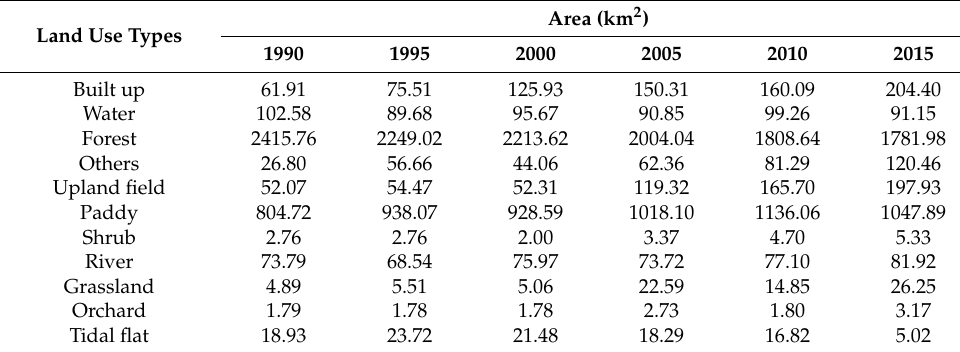
Table 5. Area of land use types in Vientiane from 1990 to 2015.